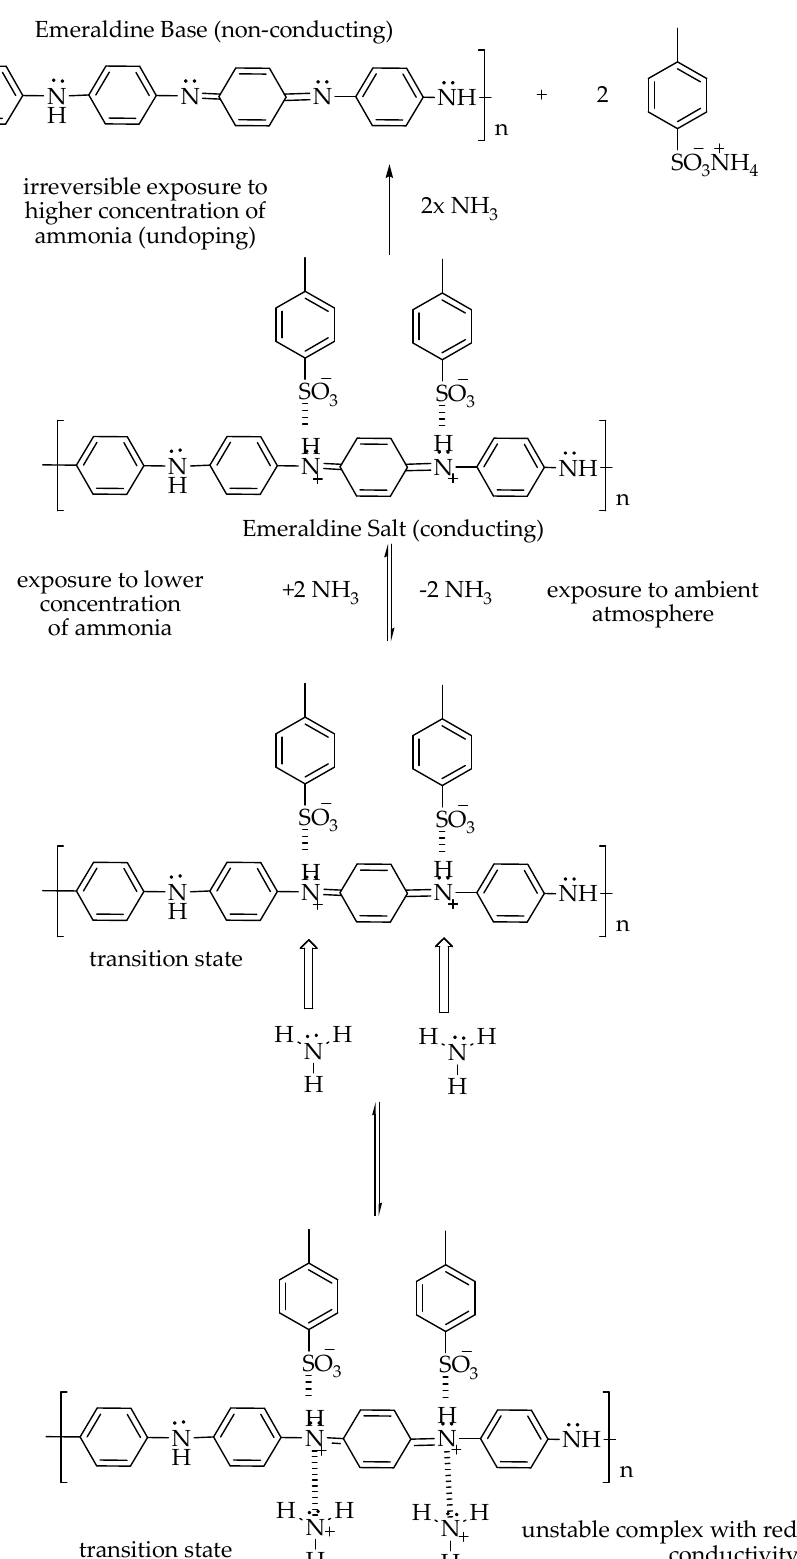
Figure 17. The schematic sensing mechanism of PANI, which involves the chemisorption–desorption phenomenon and electrical compensation.